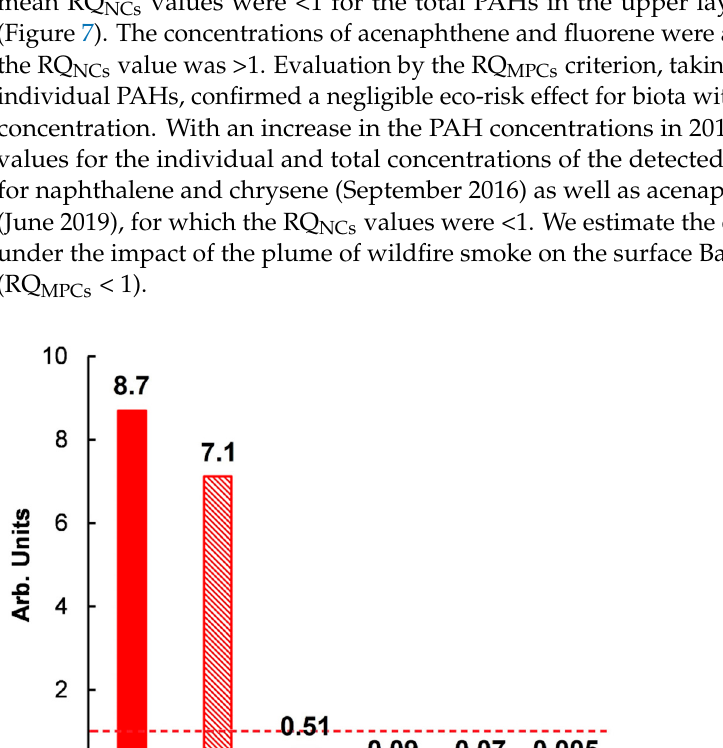
mean RQ NCs values were ˂ 1 for the total PAHs in the upper layer of the pelagic zone (Fig- ure 7). The concentrations of acenaphthene and fluorene were an exception, for which the